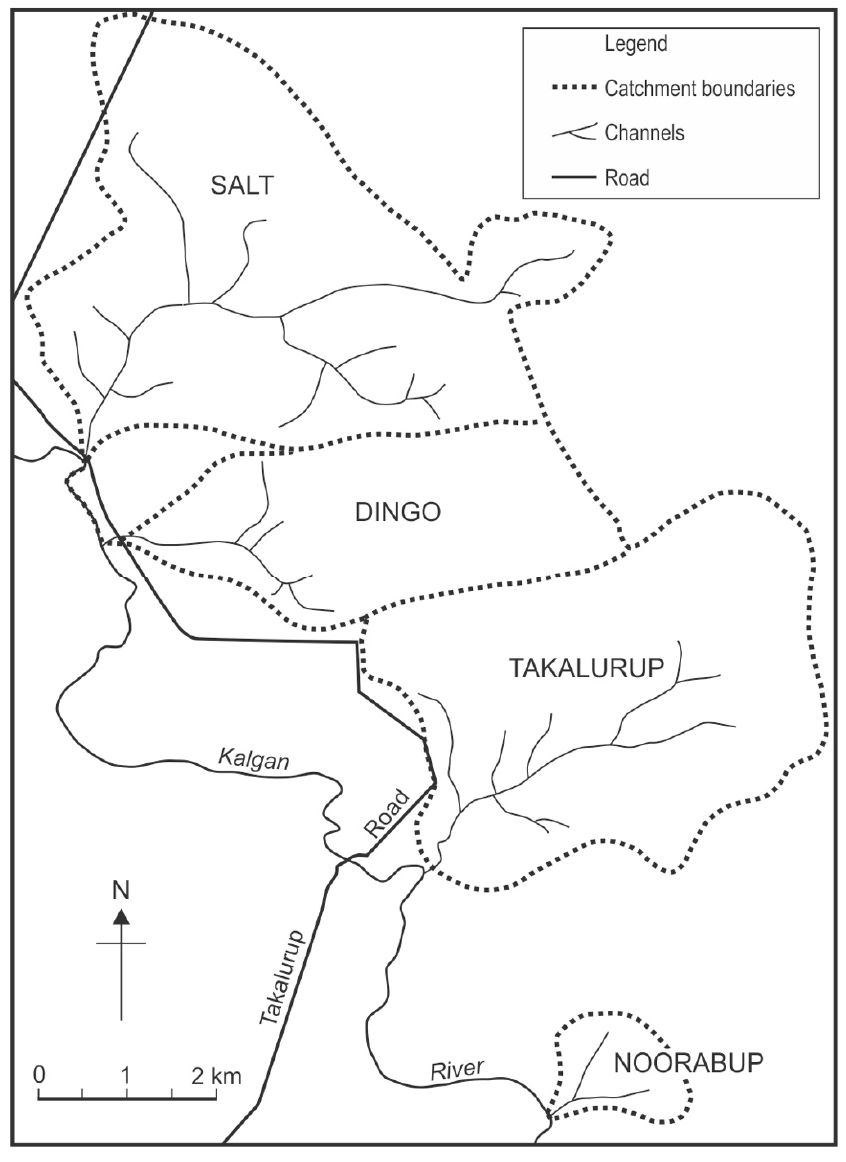
Figure 2. The study catchments.